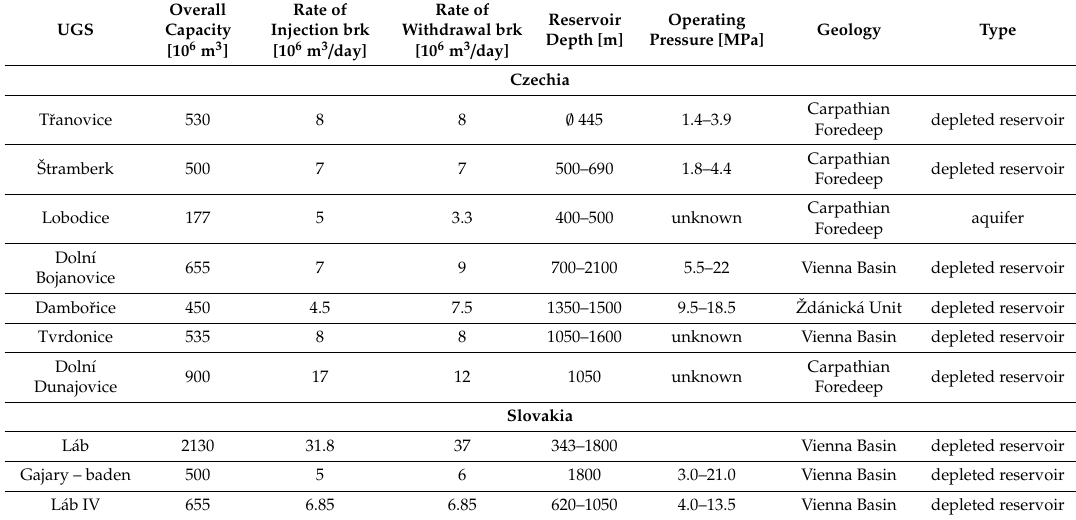
Table 1. Parameters of the evaluated UGSs